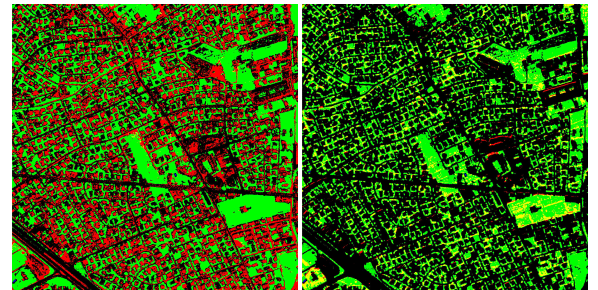
Figure 2: Classifications derived from pan sharpened TOA im- age, left: water (blue), vegetation (green), sealed/soil (red), dry vegetaion (yellow), right: water (blue), vegetation (green), shadow (red), shadow+vegetation (yellow, mostly near trees)